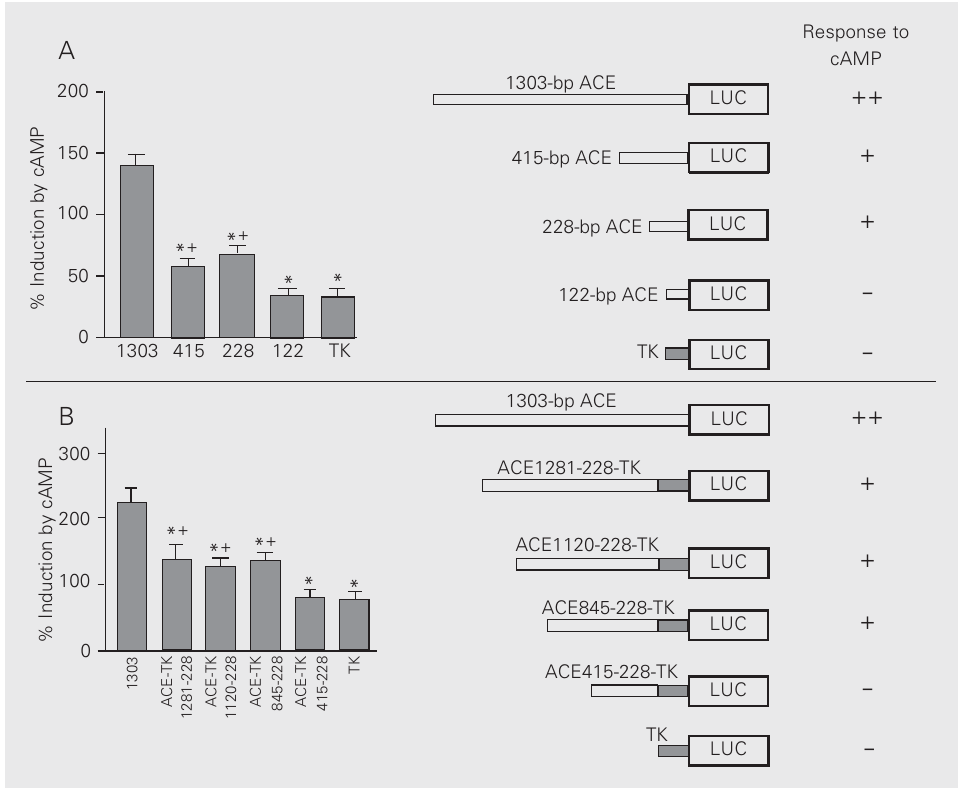
Figure 2. Mapping of the angiotensin converting enzyme (ACE) promoter response to cAMP in an endothelial cell line (REC). A , The wild type 1303-bp ACE promoter, three deletion mutants (415, 228 and 122 bp) and thymidine kinase (TK), a negative control, were transfected in REC to identify promoter sequences involved in the response to cAMP. After 24 h of transfection cells were serum-starved for 16-24 h in F12 supplemented with 0.5% FBS. 8BrcAMP was then administered to the cells at a concentration of 5 mM for 4 h. Luciferase (LUC) activity in cell extracts was normalized for beta galactosidase expression from a control plasmid. Promoter activity is the ratio of luciferase/beta galactoside expression. Data are reported as percent induction compared to control values for each construct. Data are reported as the mean ± SEM for 4 independent experiments (N = 4 in each). B , Mapping of cAMP responsiveness in distal ACE promoter sequences. The 1303-bp ACE promoter and hybrid ACE-TK constructs were transfected in REC to narrow the large distal interval containing cAMP-responsive elements between nucleotides 415 and 1303. Fragments 228 to 415, 228 to 845, 228 to 1120, and 228 to 1281 bp of the ACE promoter were placed upstream from the TK promoter. Transfections and stimulations were performed as above. Data are reported as percent induction compared to control values for each construct. Data are reported as the mean ± SEM for 5 independent experiments (N = 6 in each). *P < 0.05 compared to 1303 bp, + P < 0.05 compared to TK